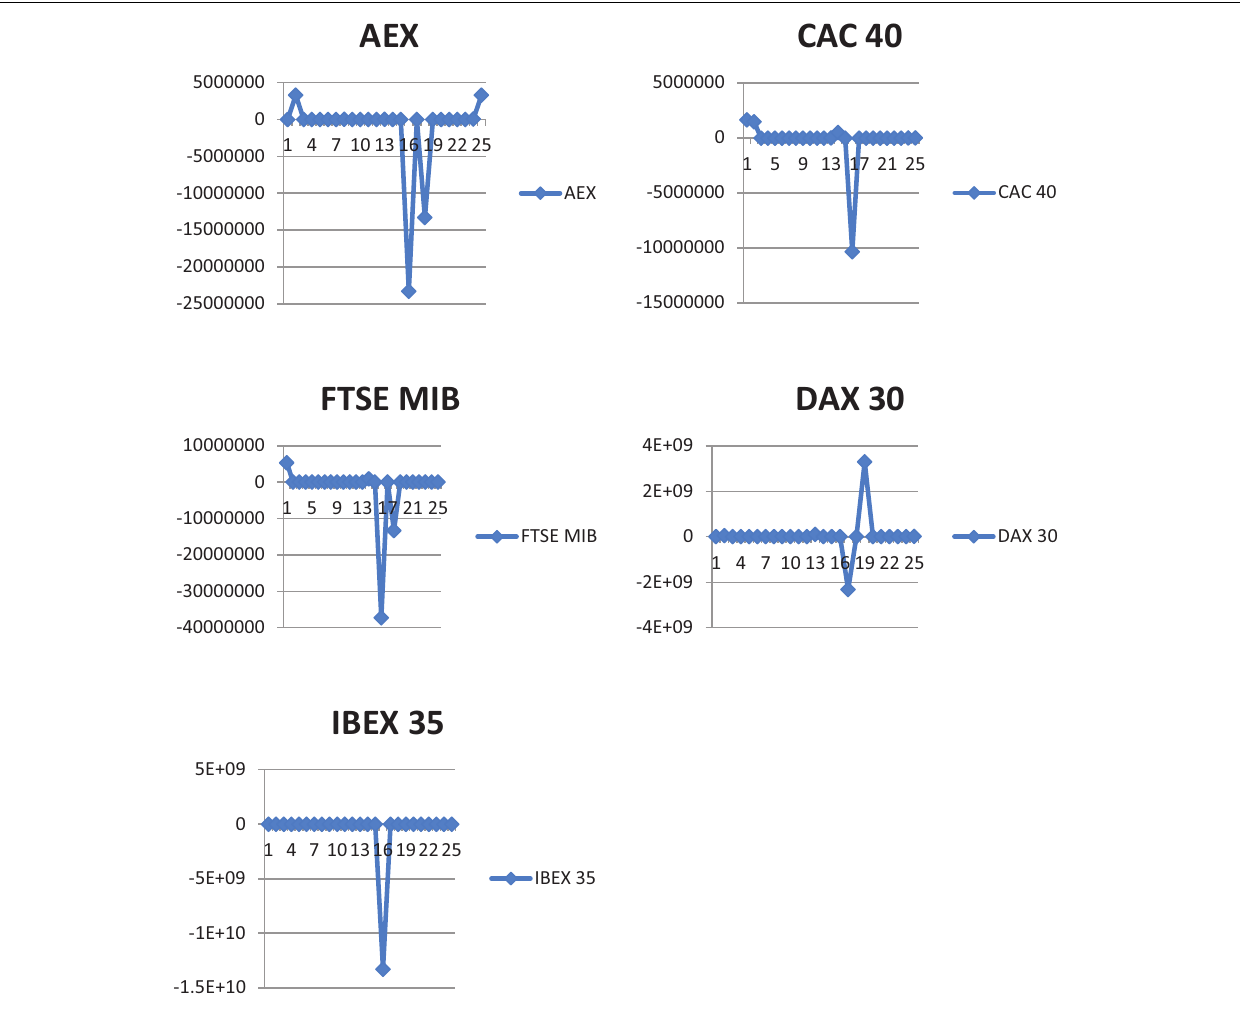
Frontiers in Psychology |